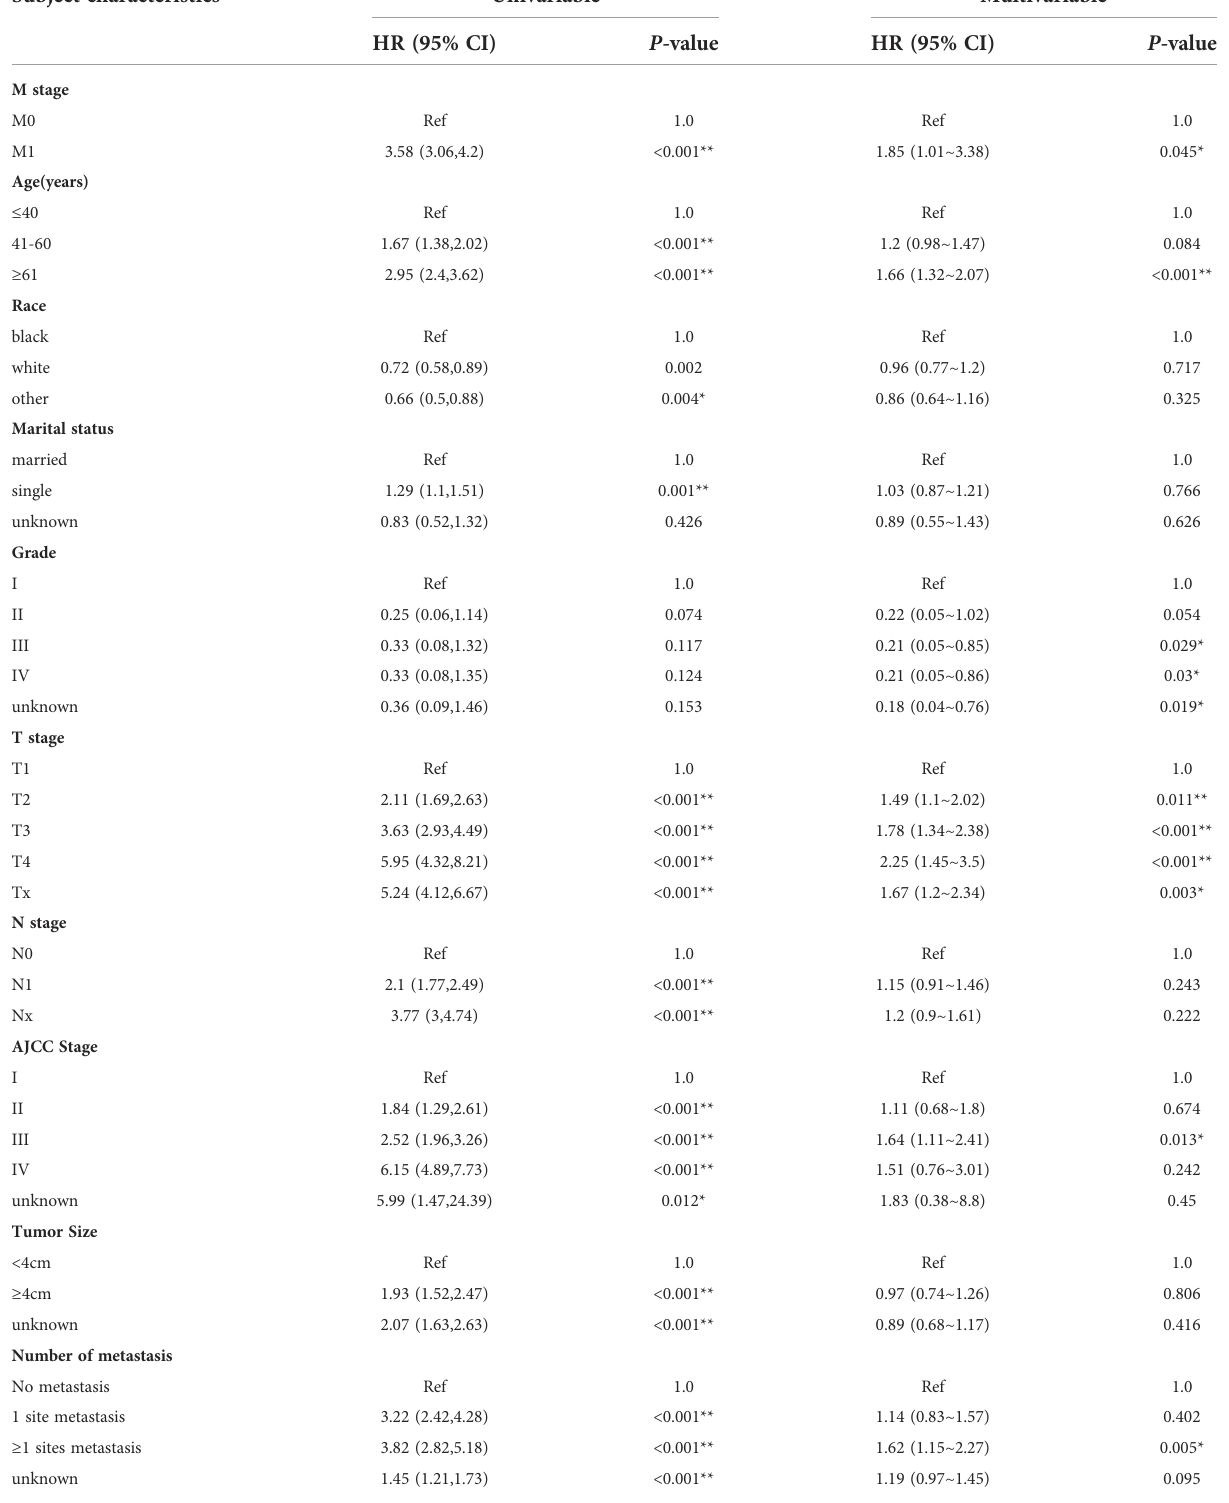
TABLE 3 Univariable and multivariable Cox regression analysis of overall survival in neuroendocrine cervical cancer patients with metastasis in SEER database (2000 –